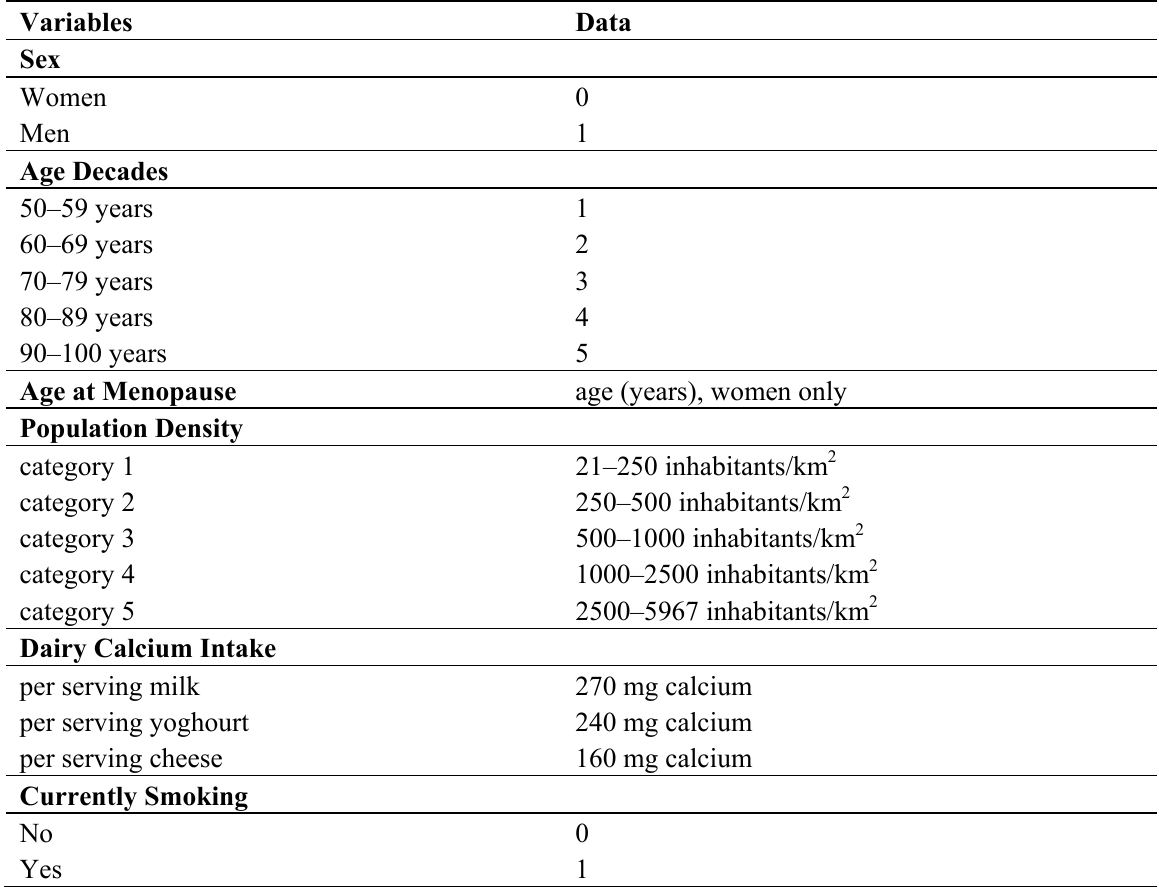
Table 2. Variables of a Dutch cohort after a recent